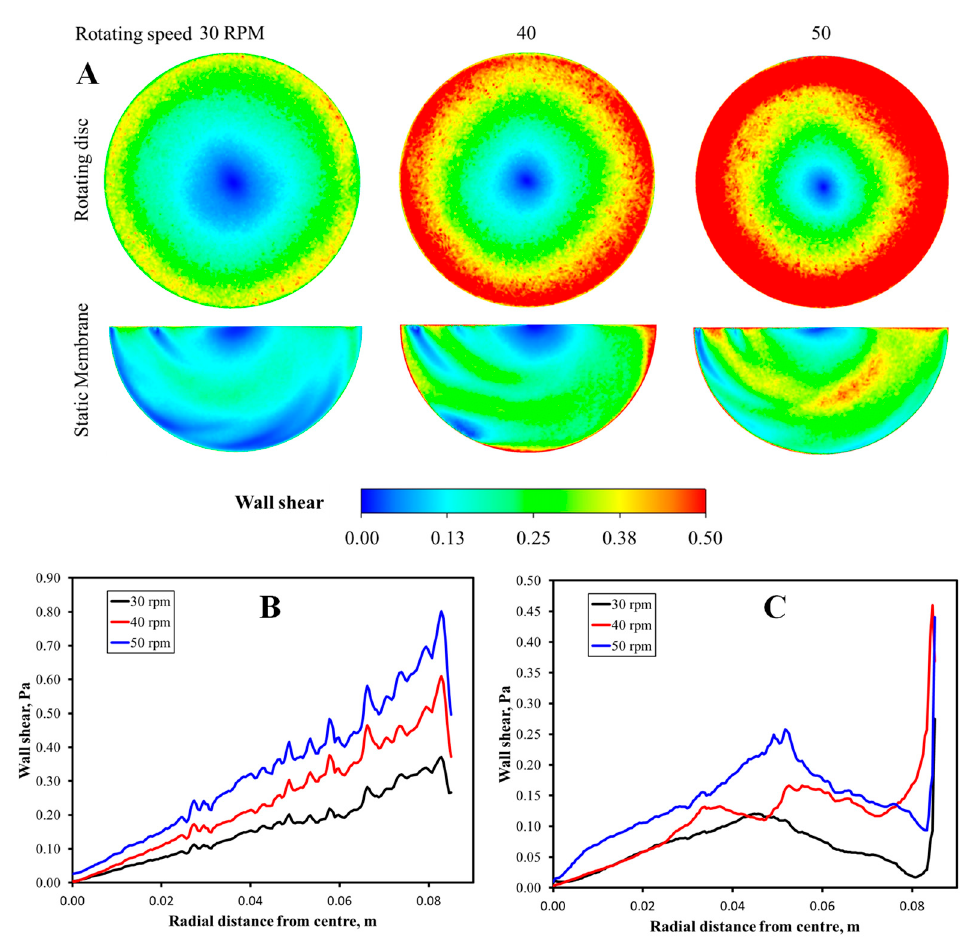
Figure 6. ( A ) Visualization of wall shear and its profile as a function of the radial distance on the surface of ( B ) rotating spacer and ( C ) the static membrane surface.